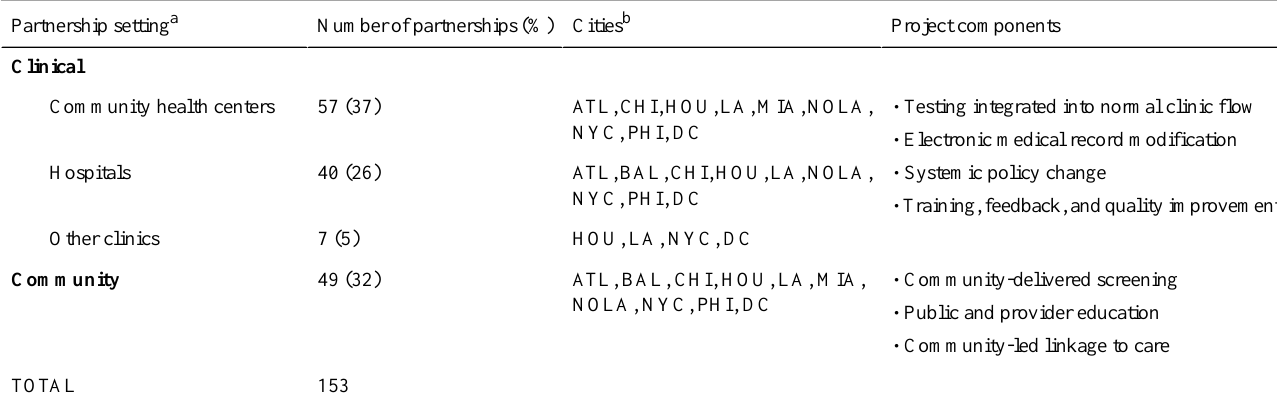
Table 1. Characteristics of FOCUS partnerships,